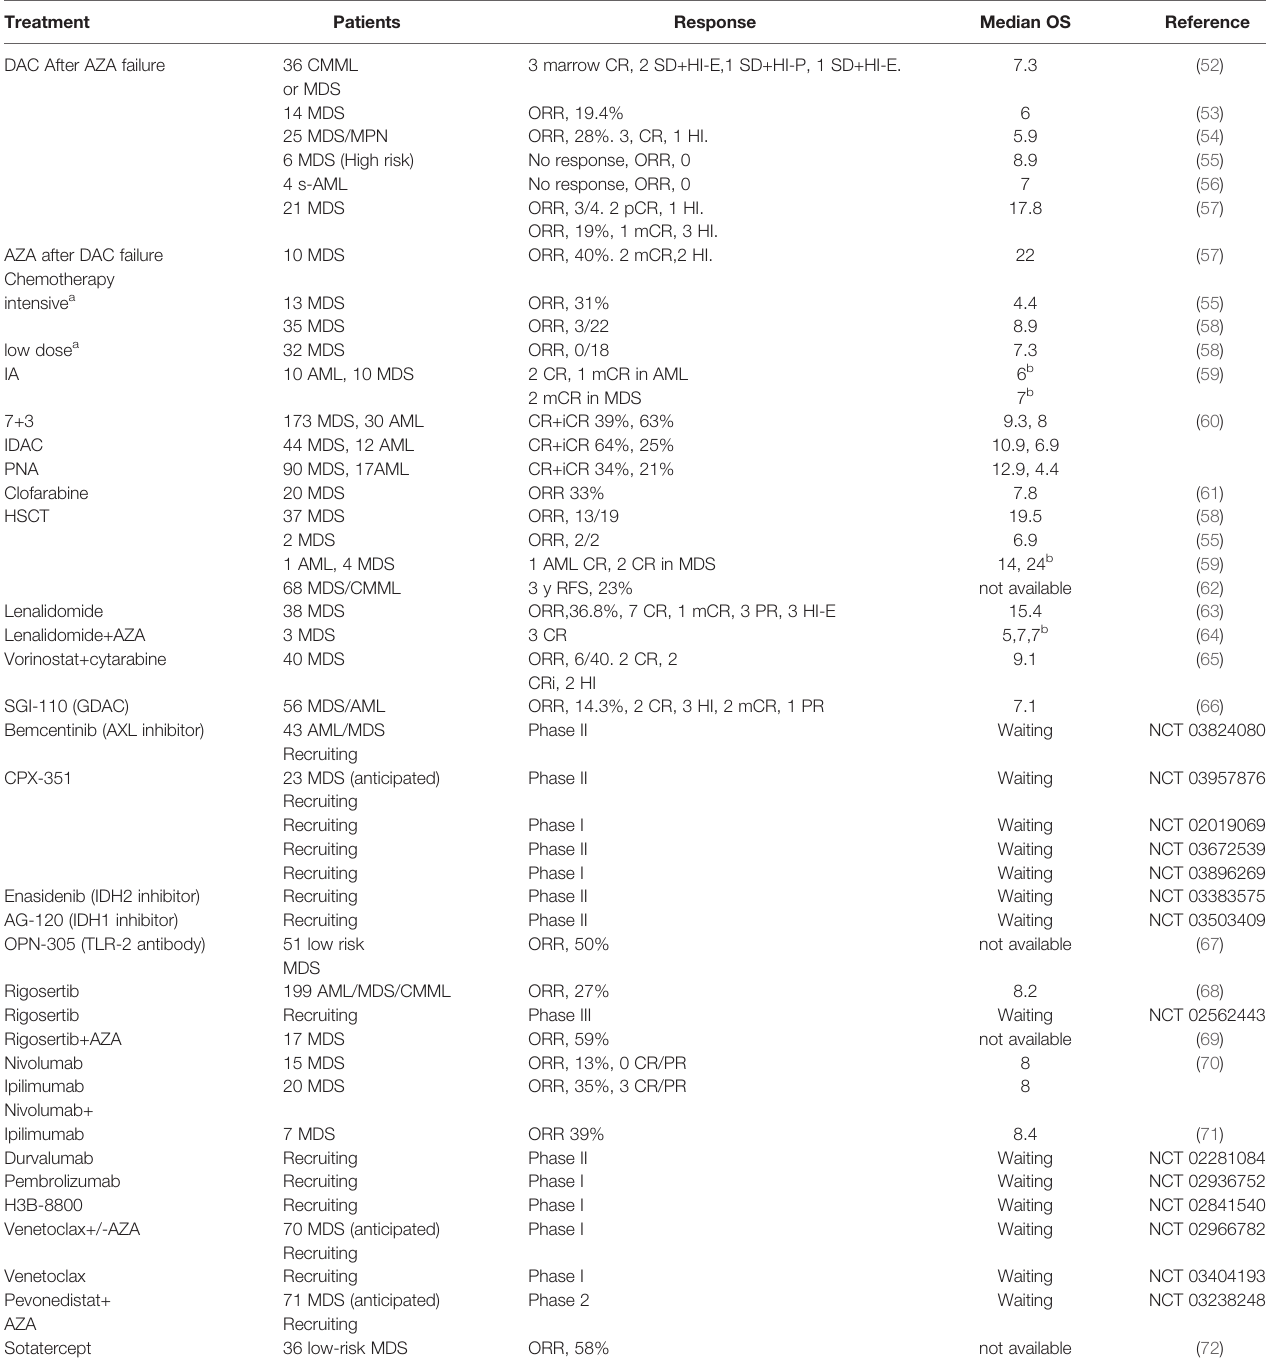
TABLE 2 | Different strategies for patients with HMA